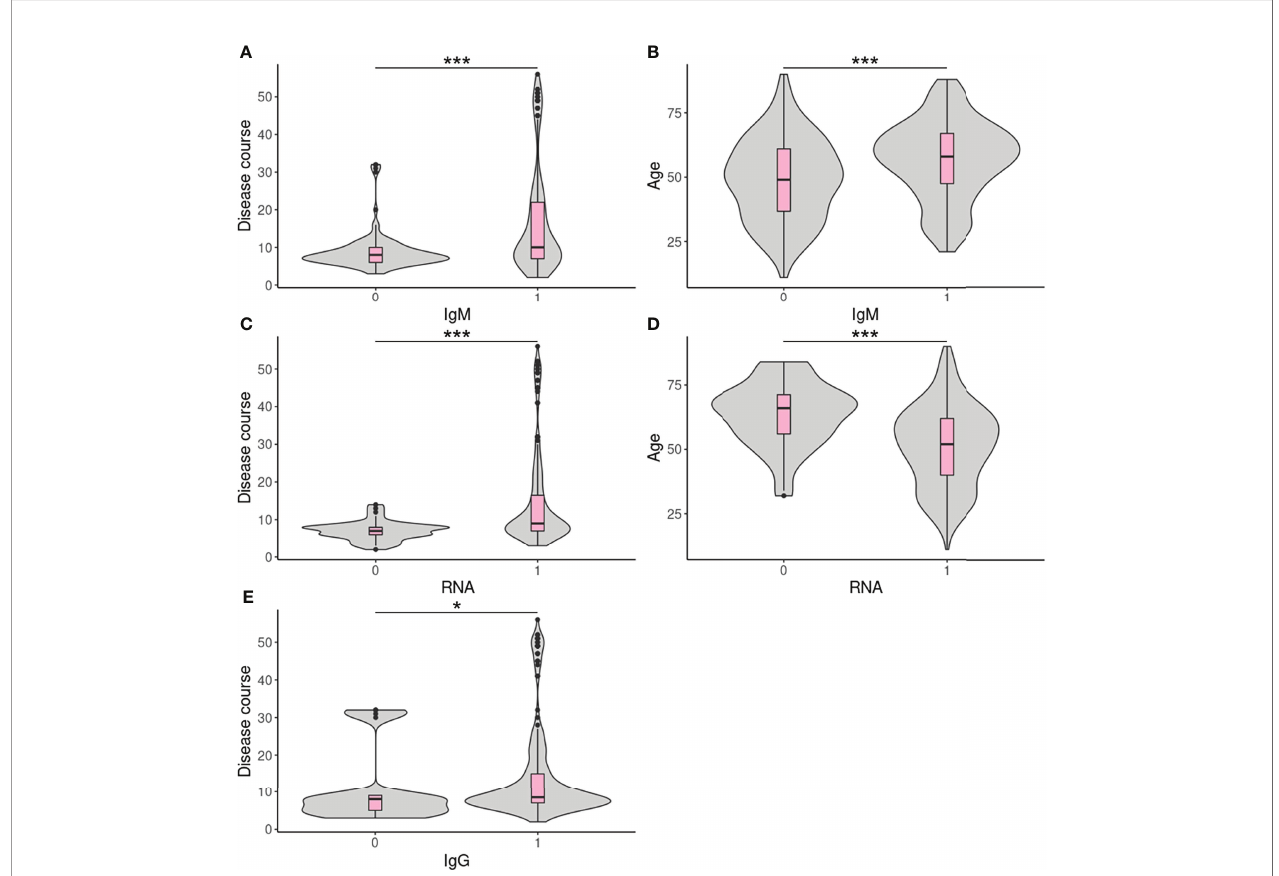
FIGURE 3 | Continuous correlated factors in HBCDC. (A – E) Boxplots of continuous correlated factors in HBCDC. 0: negative result; 1: positive result. *p < 0.05, ***p <